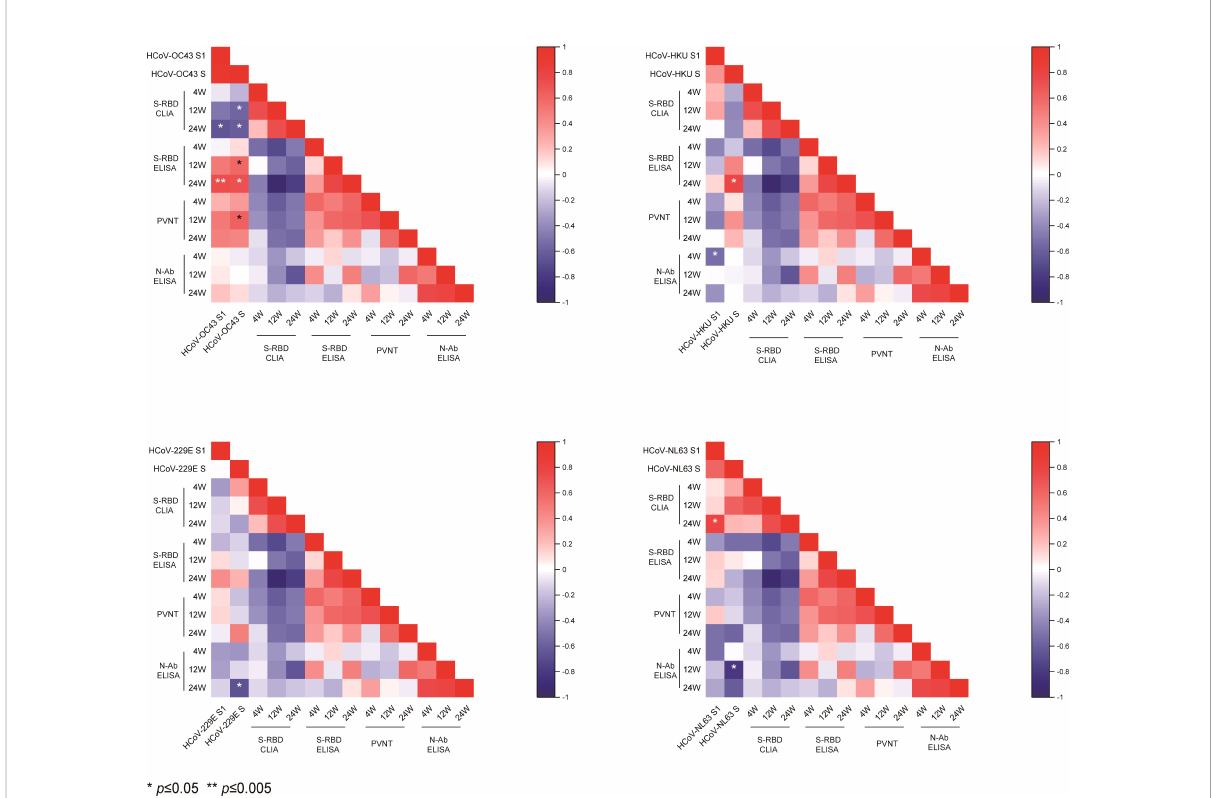
FIGURE 3 Pearson correlation matrices of antibody levels to SARS-CoV-2 and seasonal HCoVs. Heat map of the Pearson correlation matrices of pre- existing spike and S1 subunits ’ IgG antibody levels to seasonal HCoVs (HCoV-OC43, HCoV-HKU1, HCoV-NL63, and HCoV-229E) and S-RBD/N antibody and nAbs to SARS-CoV-2 at 4, 12, and 24 weeks after vaccination. Statistically signi fi cant correlations are indicated with an asterisk (*) in the fi rst two columns of every heat map. * P < 0.05, ** P < 0.005.